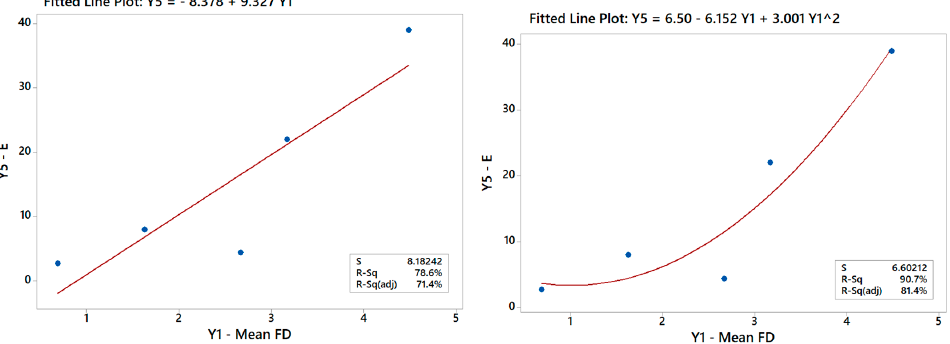
Figure 14. Linear model of Y 5 vs. Y 1 indicating a good correlation between these output variables.